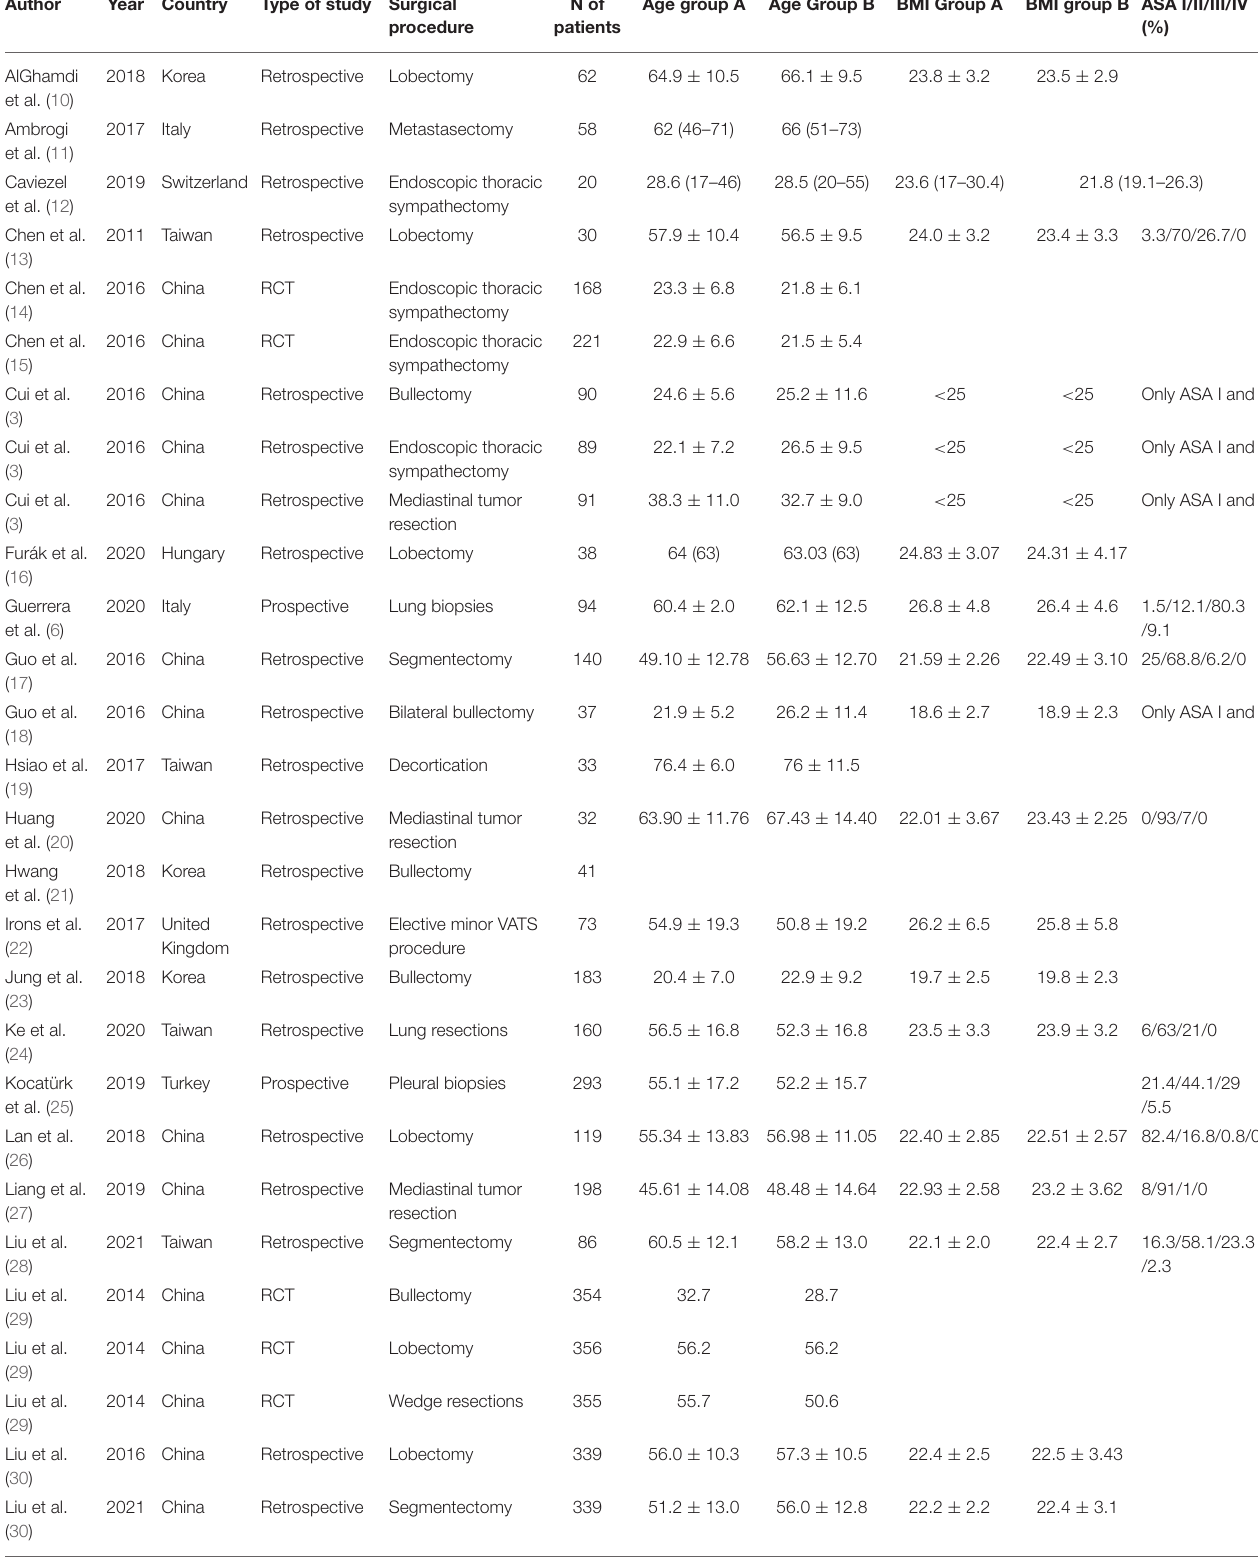
TABLE 1 | Summary table of population characteristics of single-cohort observational